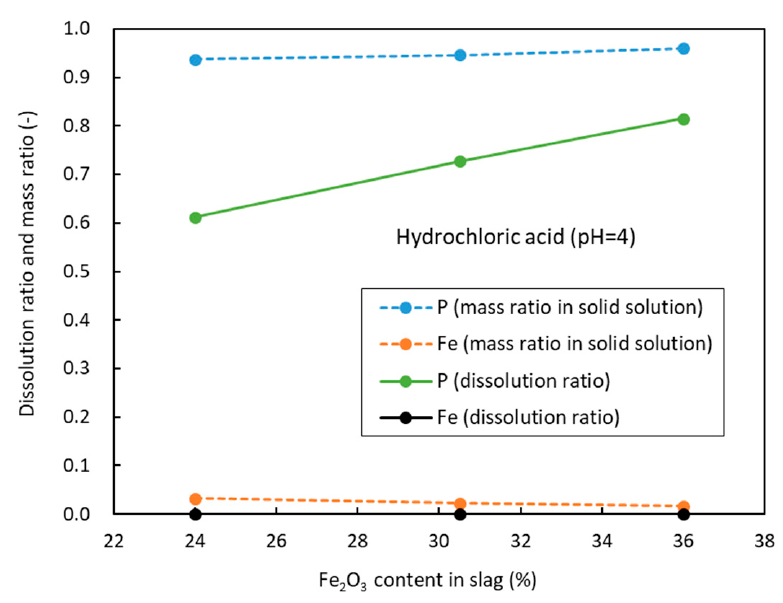
Figure 9. Dissolution ratio of P from different types of dephosphorization slag and the mass ratio of P in the solid solution.